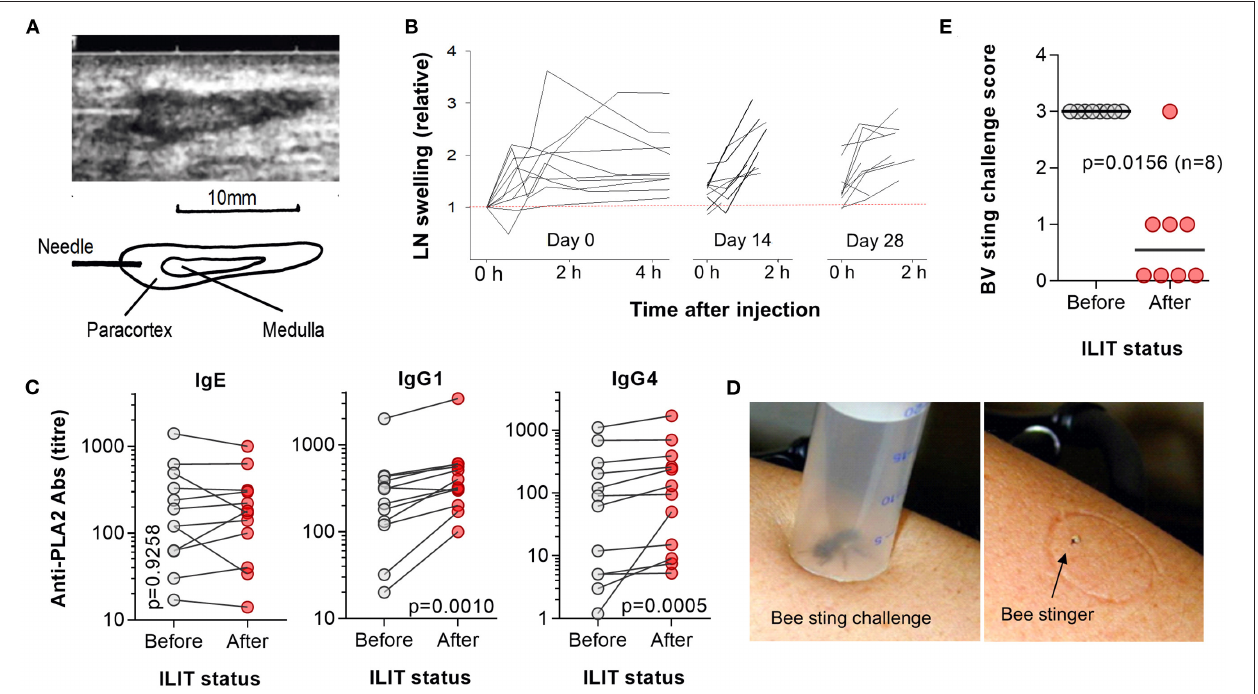
FIGURE 2 | Assessment of node swelling, antibody responses, and honeybee provocation test. (A) Ultrasound imaging was applied to guide an injection and to document possible changes in the lymph node structure. (B) Sonographic monitoring of lymph node swelling for 2–4h post first ILIT injection at each of the three ILIT sessions on days 0, 14, and 28. (C) Patient blood analyzed prior to the first bee venom ILIT and 4 weeks after the last ILIT. The sera were measured by ELISA for IgE, IgG1, and IgG4 antibodies against the major bee venom allergen PLA2 and expressed as titer. Statistical differences were analyzed by Wilcoxon matched-pairs signed-rank tests. (D) A honeybee was trapped in a prepared syringe, the plunger lowered to provoke a sting, and the stinger left on the skin for 60min while monitoring local and systemic reactions. (E) Eight patients were subject to a bee sting challenge prior to the first bee venom ILIT and 4 weeks after the last ILIT. While all patients exhibited grade III allergic reactions to bee stings prior to vaccination, after treatment, only one grade III reaction and three cases of grade I reactions occurred. In the remaining four patients, there was no systemic allergic reaction to the challenge. The value of p was calculated by Wilcoxon matched-pairs signed-rank